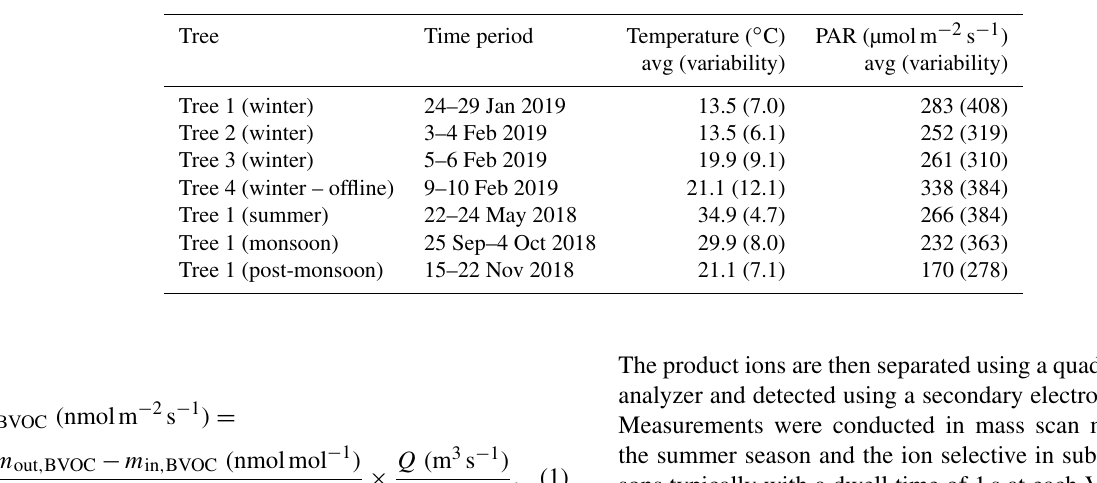
Table 1. Summary of the sampling details of all the four trees with average temperature, photosynthetic active radiation (PAR) and variability as standard deviation of the average in